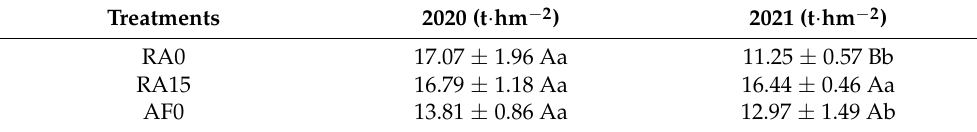
Table 2. AGB in different systems.